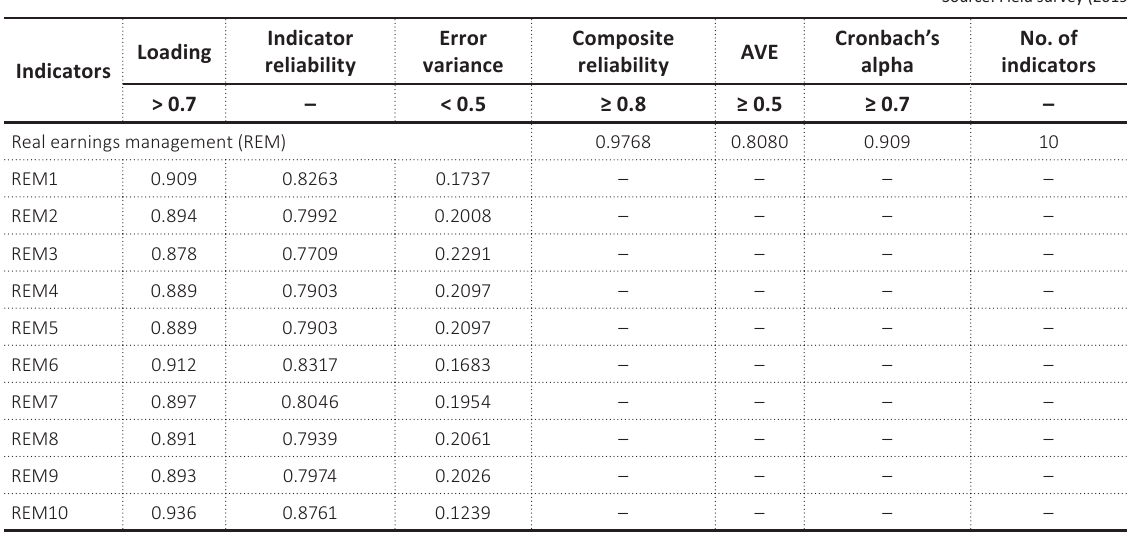
Table A4. Sample